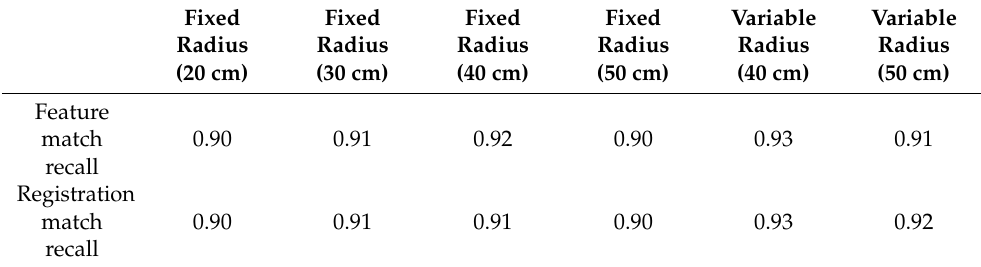
Table 2. The recall of different fixed radius and gradient radius in the Home1 category of 3DMatch.